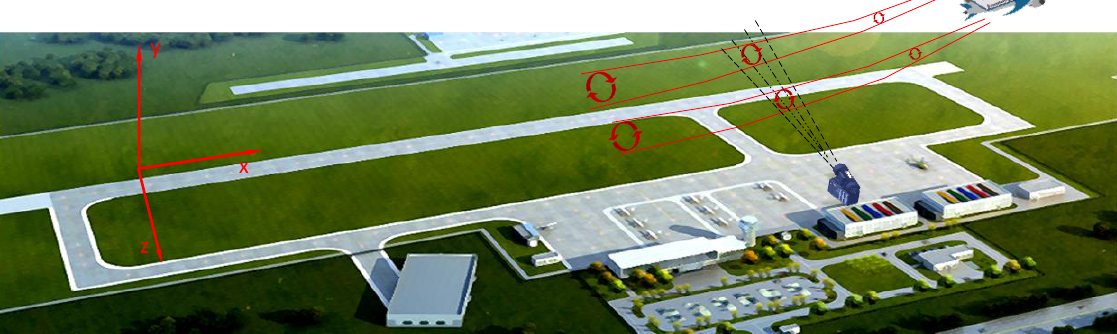
Figure 2. The lidar working in RHI mode for aircraft wake recognition.